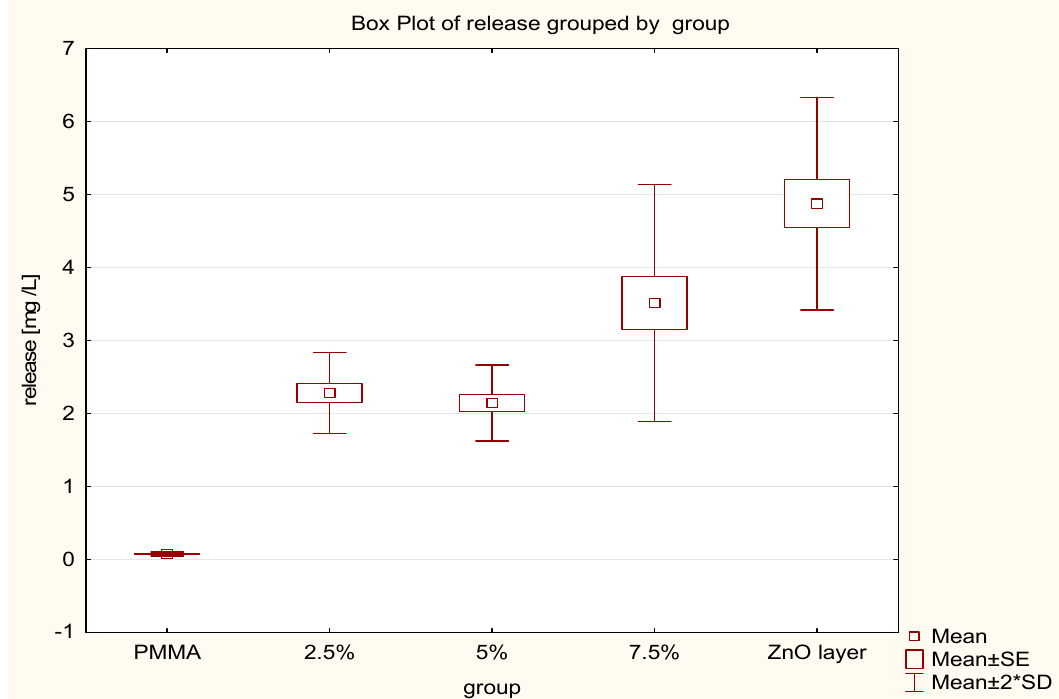
Figure 1. Plot of the ZnO release from nanocomposites.